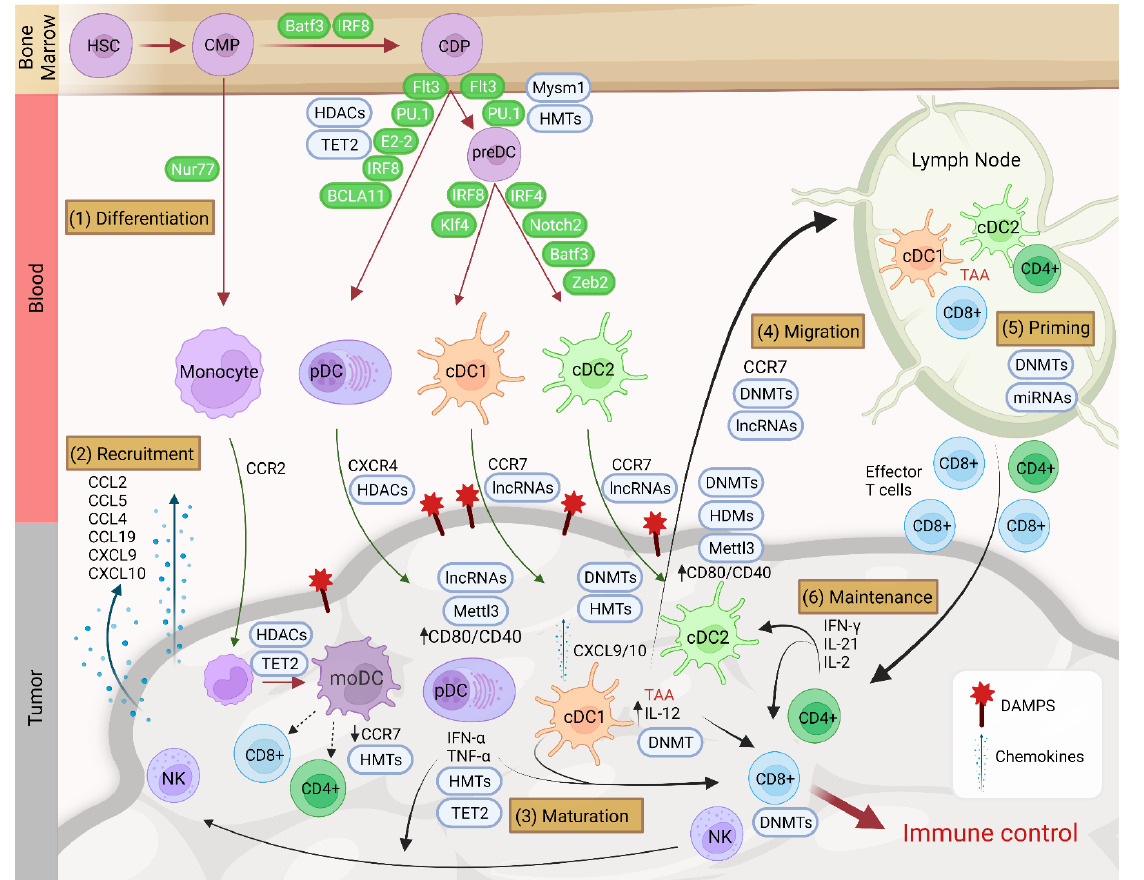
Figure 1. (1) Dendritic cells are originated from hematopoietic stem cells (HSC), which differentiate (represented with red arrows) into common myeloid progenitor (MDP) in the bone marrow. MDP can originate monocytes under the regulation of TF Nur77 or differentiate into common dendritic progenitor (CDP) under the TFs Batf3 and IRF8. Conventional type 1 DC (cDC1), conventional type 2 DC (cDC2), and plasmacytoid DC (pDC) subsets come from CDPs, under the influence of critical TFs and growth factors (shown next to each red arrow). (2) Under the expression of damage-associated molecular patterns (DAMPs) and chemokines like CCL2, CCL5 or CCL19 from the tumor the different DCs and monocytes are recruited in the tumor (represented with green arrows). This recruitment is guided by the expression of CCR2, CXCR4 and CCR7 in myeloid cells. (3) Once in the TME, DCs mature. This involves the upregulation of CD80/CD40 and the release of interleukin-12 (IL-12). In the case of cDC1, maturation processes also involve the expression of additional chemokines like CXCL9/10. Monocytes can further differentiate into monocyte-derived DCs (moDCs) in the tumor conditions. These cells have low expression of CCR7, which reduce their migration capacity. However, these cells are capable of activating CD4+ and CD8+ T cells within the tumor. (4) After tumor associated-antigen recognition (TAA), DCs migrate (represented with black arrows) to lymph nodes and (5) prime naïve CD4+ and CD8+ T cells. (6) After T cell activation, T cells migrate to the tumor and a constant cross-talk is produced between DCs and T cells to produce a correct immune control and maintenance. This maintenance consists in the expression of cytokines like interferon-α (IFN-α), tumor necrosis factor (TNF)-α from pDC or IL-12 from cDC that, in turn, is amplified by T- and natural killer (NK) cell–derived cytokines such as IFN-γ, IL-2 and IL-21. NKs can also be implicated in the release of chemokines, which will attract more DCs. During all these processes different epigenetic enzymes are implicated like ten-eleven translocation (TET)-2, DNA methyltransferases (DNMTs), histone deacetylases (HDACs), histone methyltransferases (HMTs), long noncoding RNAs (lncRNAs) or Mysm1 and the RNA methyltransferase Mettl3, represented in blue circles. Created with BioRender.com (accessed on 15 February 2022).